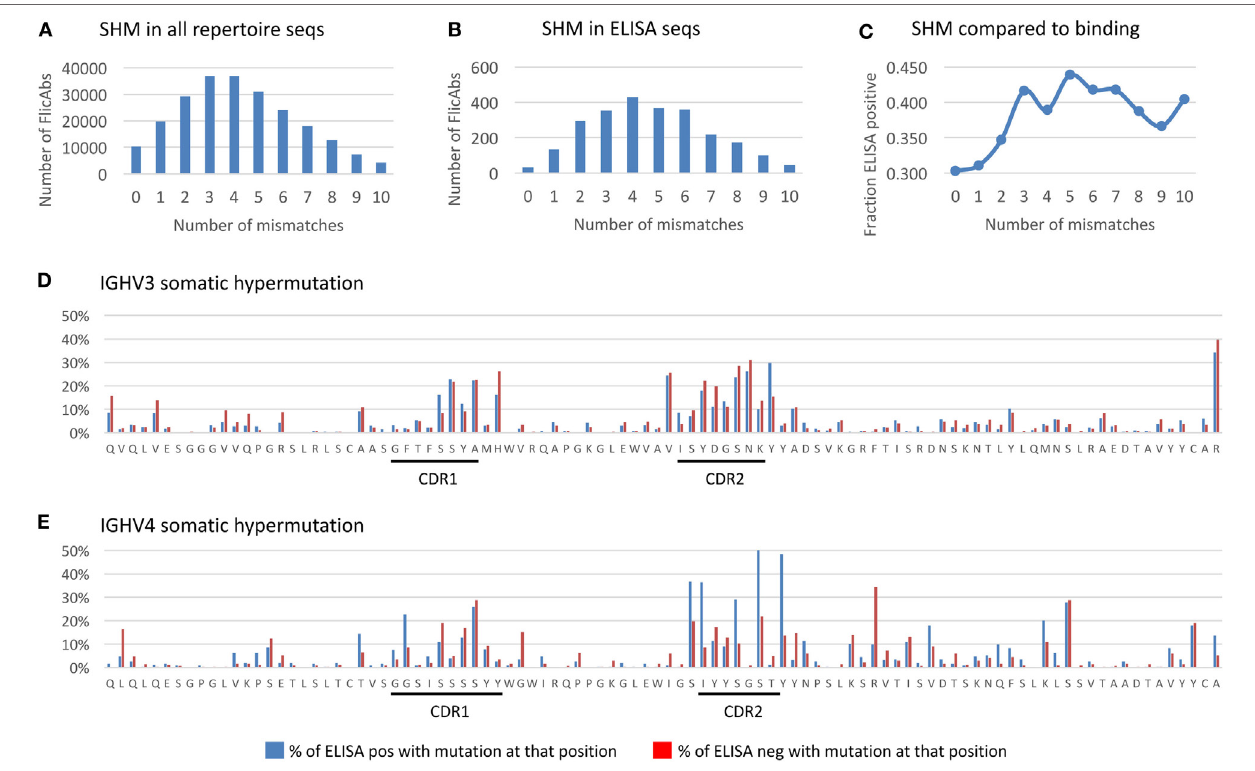
FigUre 5 | Somatic hypermutation in the heavy chain variable region. (a) The distribution of the total number of amino acid (AA) mutations in the heavy chain variable region is shown for the NGS repertoire data. The x -axis indicates the total number of AA mismatches compared with germline. The y -axis indicates the total number of FlicAbs. (B) The distribution of the total number of AA mutations in the heavy chain variable region is shown for the 2,560 sequences measured for antigen binding by ELISA. The labels are the same for panel (a) . (c) The frequency of ELISA-positive FlicAbs categorized by number of AA mismatches compared with germline is shown. The y -axis indicates the frequency of ELISA positive, and the x -axis category designates the number of mismatches compared with germline. (D) The AA mutation rates at each variable region position are shown for 1,770 sequences from the IGHV3 gene family. Blue bars indicate the percentage of ELISA-positive sequences with an AA mutation at that position. Red bars indicate the percentage of ELISA-positive sequences with an AA mutation at that position. The x -axis indicates the residue at each position of a representative germline sequence from the IGHV3 family. The y -axis indicates the percent of sequences with an AA mutation at a given position. (e) The AA mutation rates at each variable region position are shown for 615 sequences from the IGHV4 gene family. Labels are the same as panel (D)